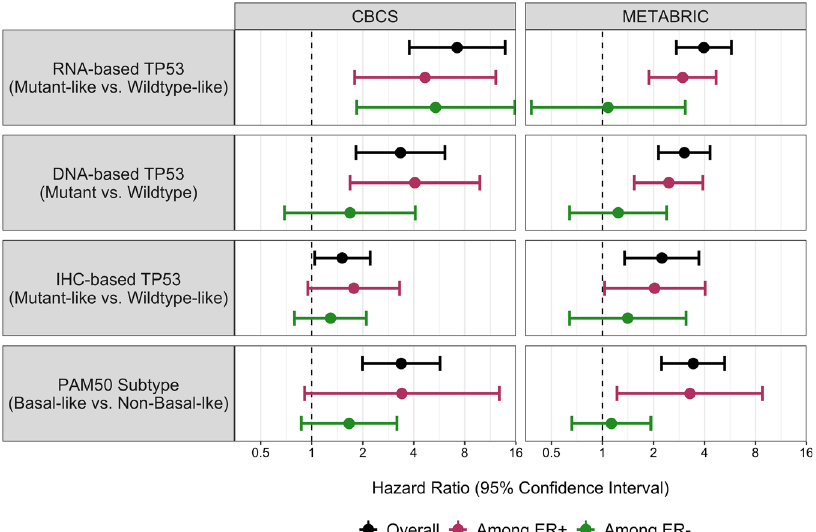
Fig. 3 Association between tumor subtype and breast cancer-speci fi c survival among breast cancer cases in CBCS and METABRIC, overall and strati fi ed by estrogen receptor (ER) status. The error bars correspond to the 95% con fi dence intervals. CBCS = Carolina Breast Cancer Study, ER = estrogen receptor, IHC = immunohistochemistry, METABRIC = Molecular Taxonomy of Breast Cancer International Consortium, PAM50 = Prediction Analysis of Microarray